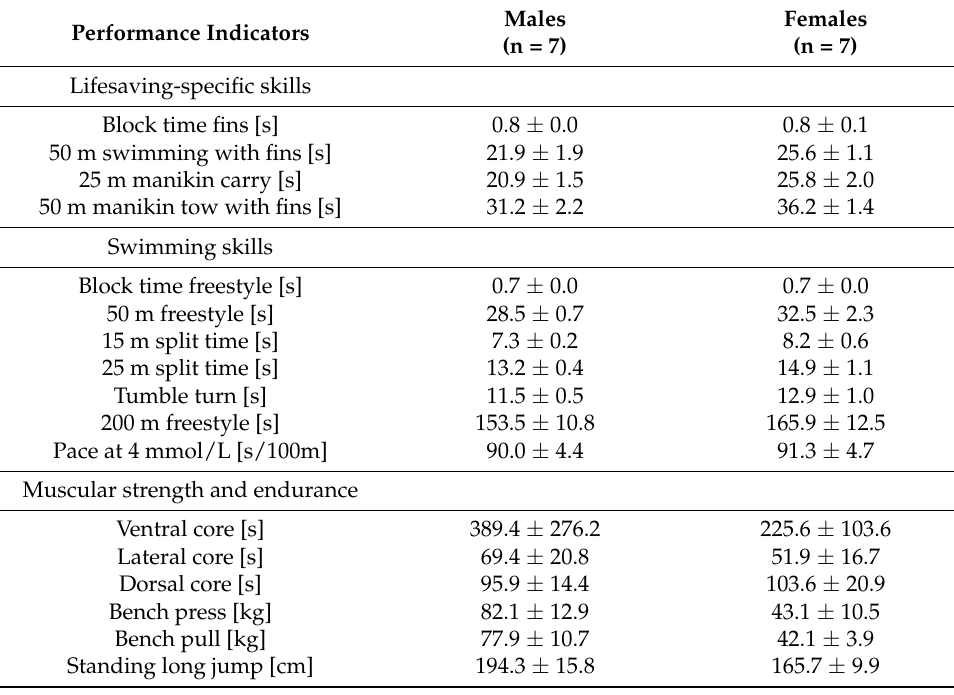
Table A1. Descriptive data (mean ± standard deviation) for the performance